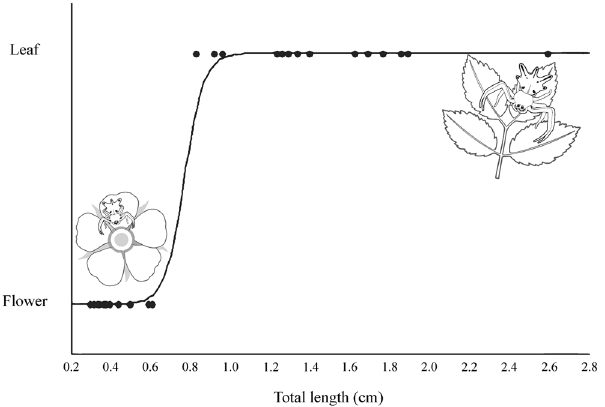
Figure 4. Ontogenetic habitat shift by Epicadus heterogaster . Logistic regression of probability of foraging upon flowers or leaves against body size in Epicadus heterogaster (credit to the spiders drawing: Soleman,